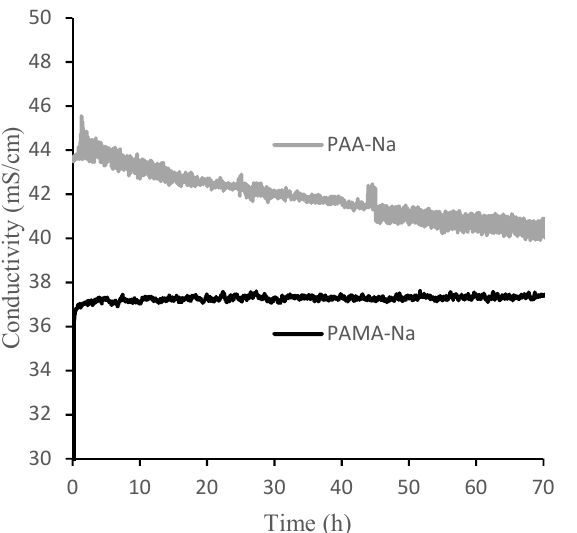
Figure 6. Conductivities of 0.3 g/mL PAA-Na and PAMA-Na draw solutions during 70 h crossflow filtration experiments.